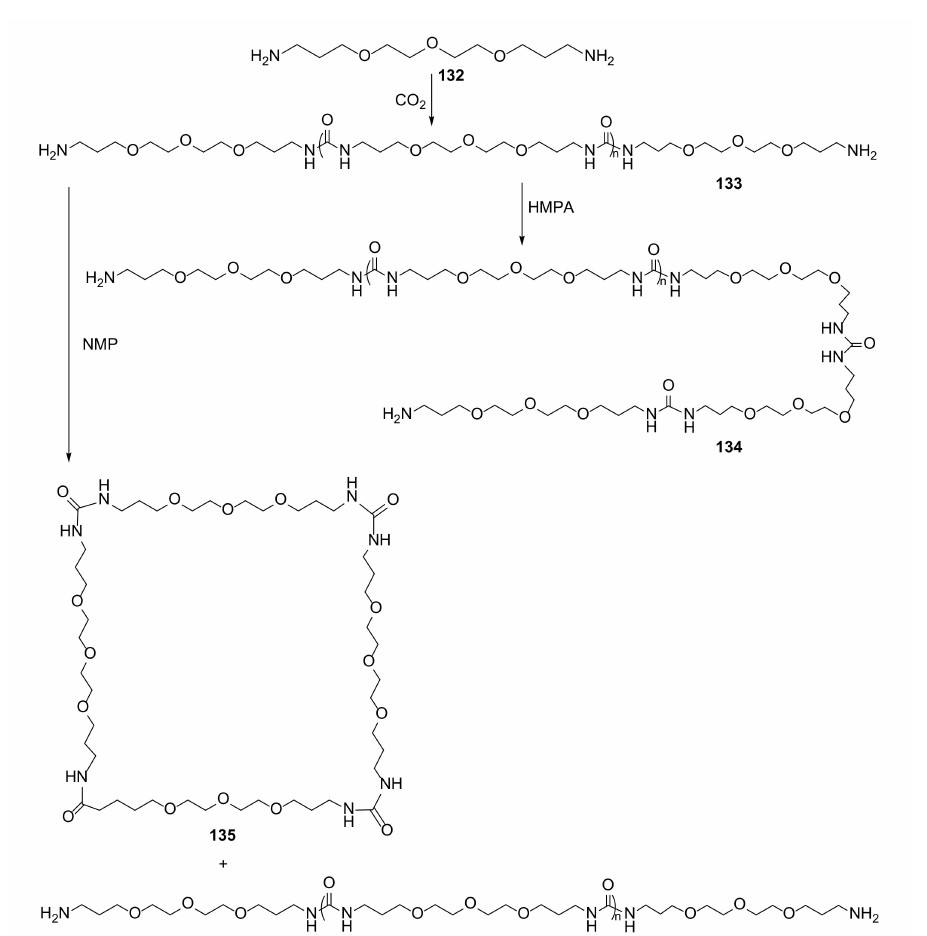
Figure 25. Macrocyclic polyurea 135 synthesis, according to the concept of green